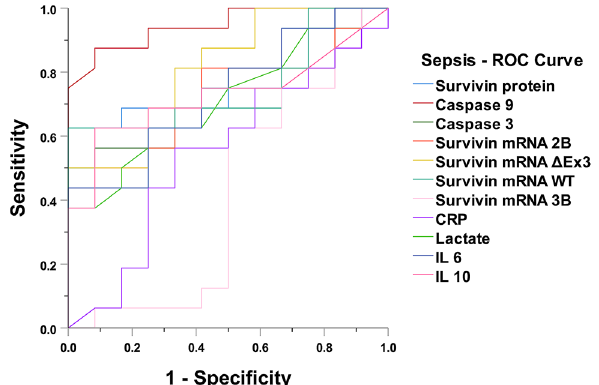
Figure 4. ROC curve for discriminating sepsis. Caspase-9 achieved the best receiver operating characteristic curve (AUROC) of 0.95 (95% CI 0.87–0.99, p < 0.001).